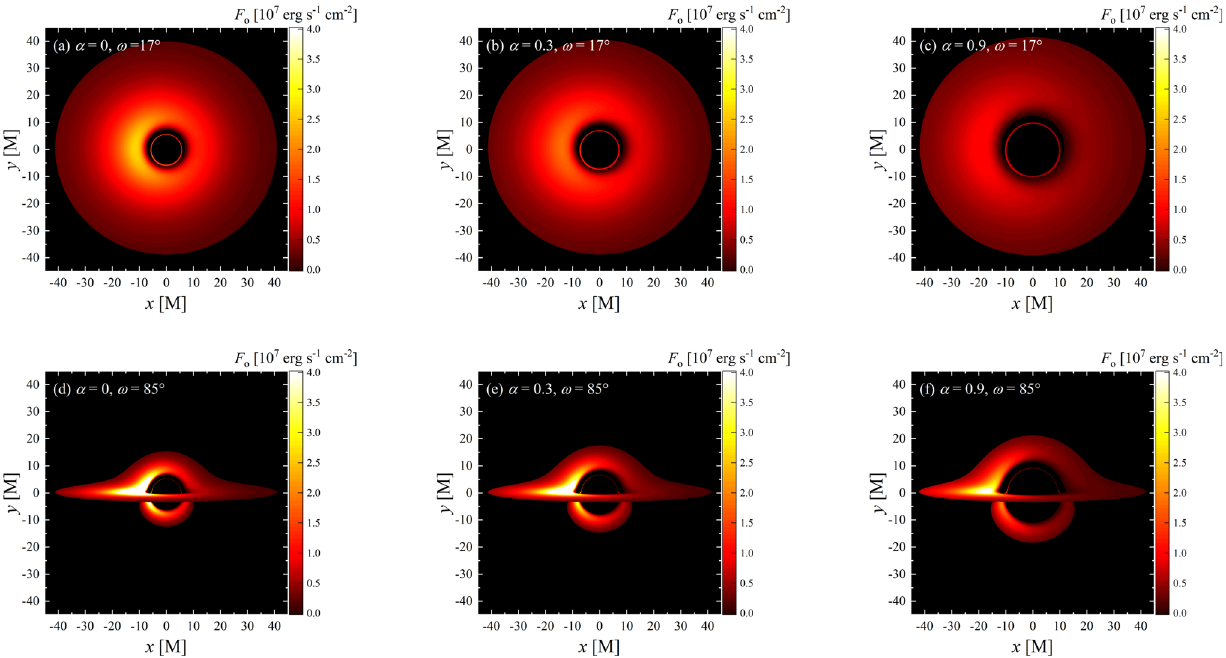
Fig. 12 The complete apparent images of the thin accretion disk for different values of parameter α and inclination ω . Each panel is composed of the superposition of direct and secondary images